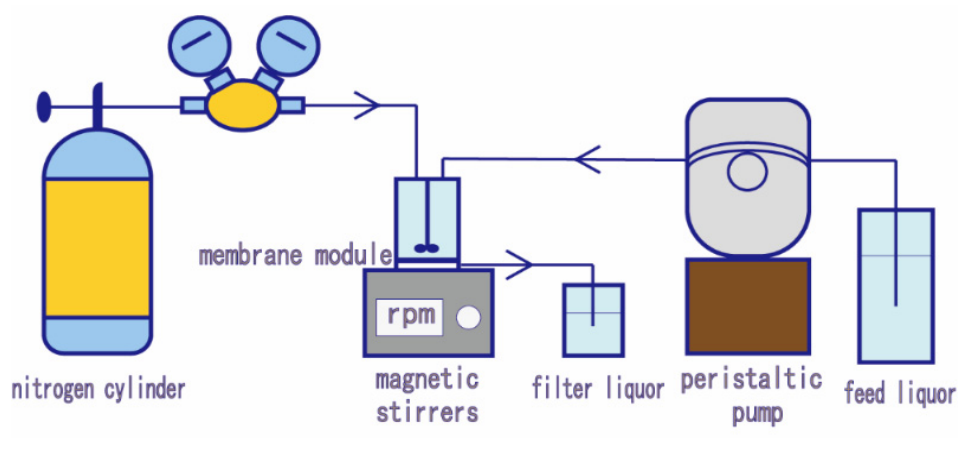
Figure 2. Lab-scale dead-end filtration unit.